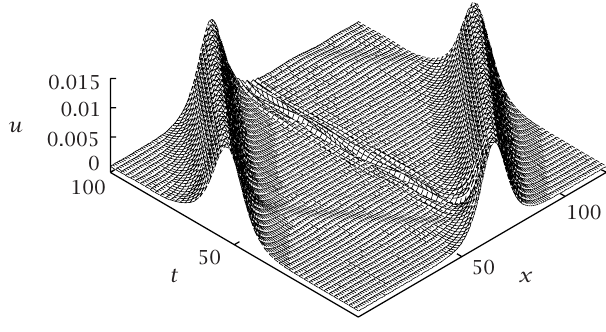
Figure 5.1. Numerical solution for a single solitary wave with ∆ t = 0 . 1 and ∆ x = 0 .